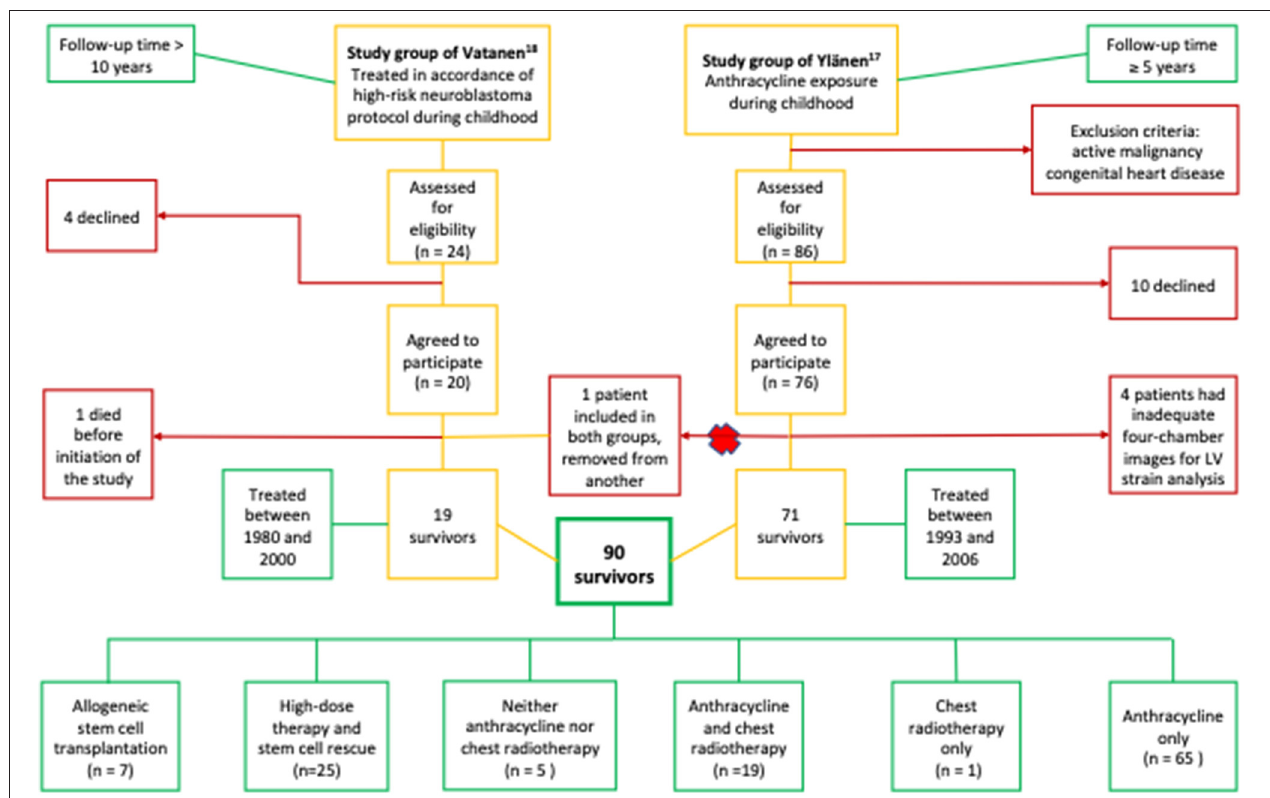
FIGURE 1 | Study recruitment and combination flow chart. The number of study patients and their cancer therapy. The majority of the patients, 94% (85/90), were treated with anthracyclines and/or chest radiotherapy. The rest (5/90, 6%) were not exposed but had received high-dose therapy and stem cell rescue. Altogether, 28% (25/90) of the patients had received high-dose therapy and stem cell rescue, and 80% (20/25) of them were also exposed to anthracyclines and/or chest radiotherapy.